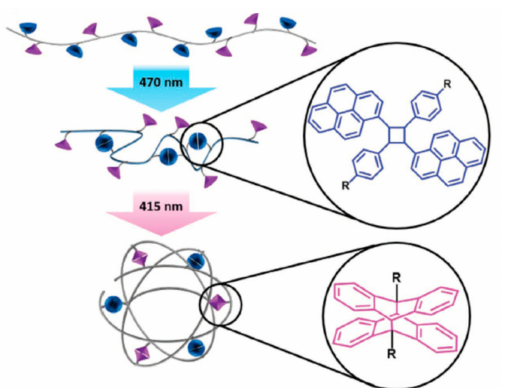
Figure 17. A schematic illustration of wavelength-selective folding of single polymer chains decorated with styrylpyrene and anthracene groups with di ff erent colors of visible light: irradiation with blue light ( λ = 470 nm) triggered the [2 + 2] photocycloaddition of styrylpyrene units as a first step, whereas violet light ( λ = 415 nm) induced the [4 + 4] photocycloaddition of anthracene groups as a second step. Reprinted from [56] with permission.